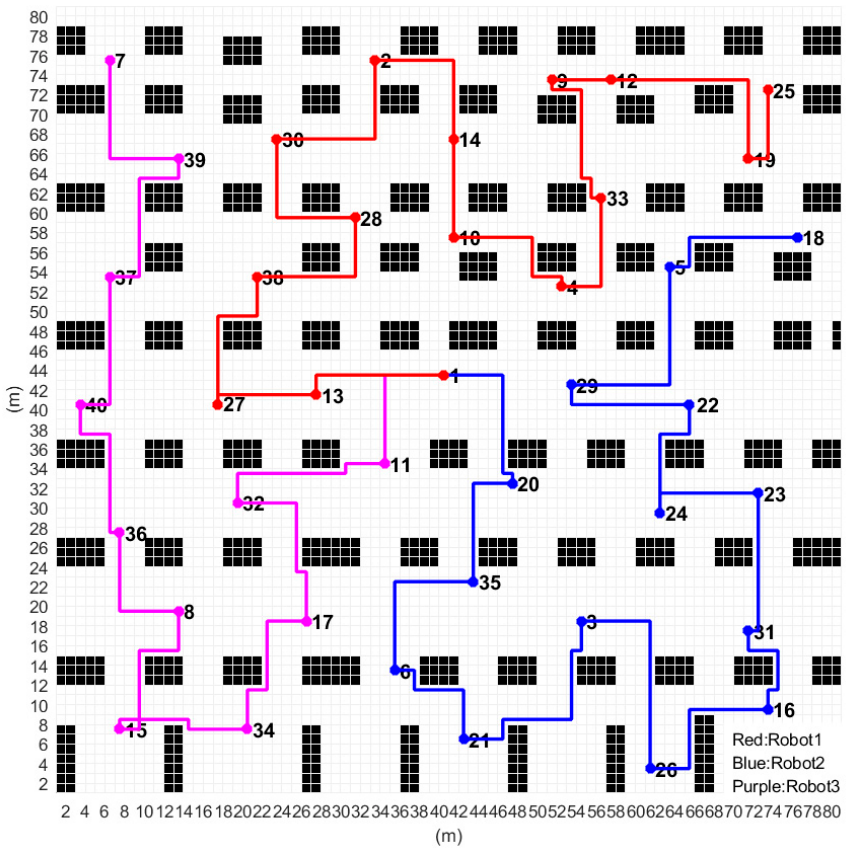
Figure 14. A* algorithm path planning diagram of the initial task sequence from Experiment 4.